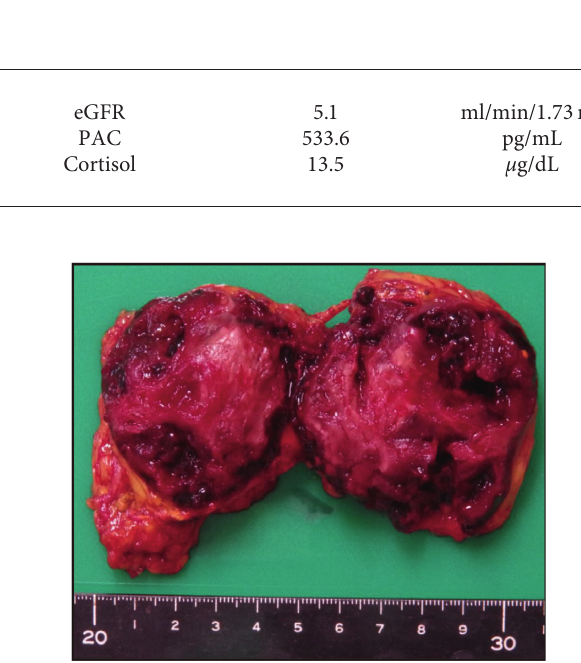
Figure 2: Gross inspection of the resected